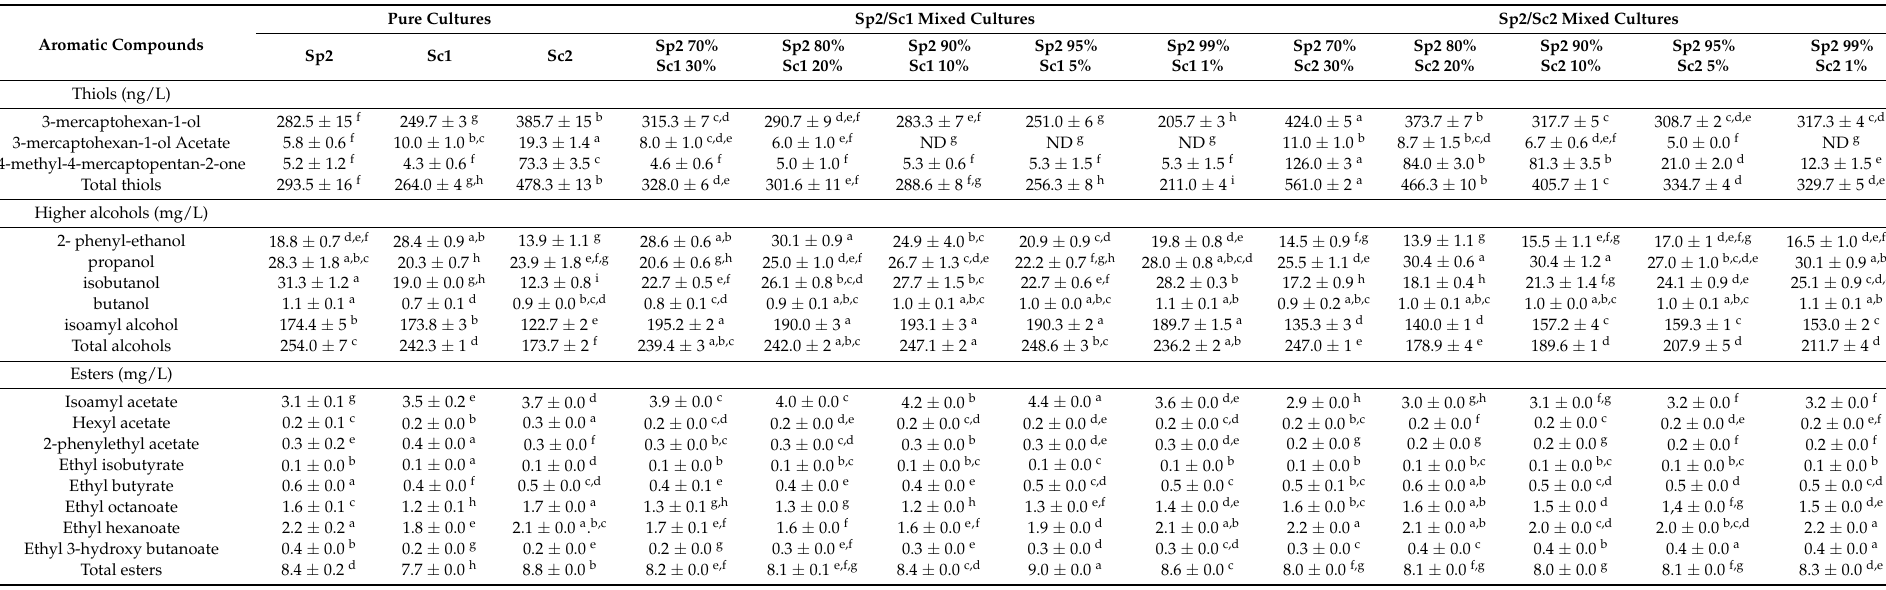
Table 2. Volatile compounds of the wines produced by pure and mixed cultures in different inoculation ratios of S. cerevisiae and S. pastorianus strains. Values with different roman letters (a–h) in the same row are significantly different according to Tukey’s post hoc test ( p <